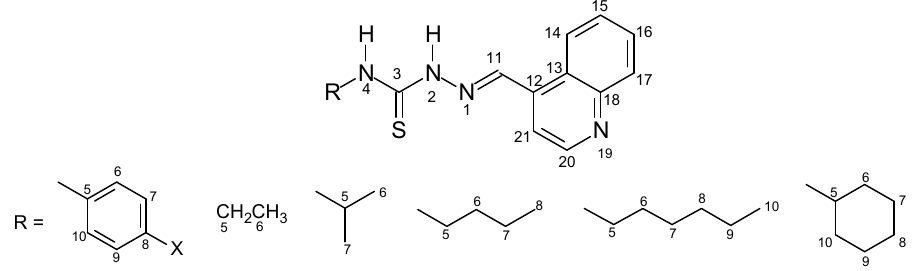
Figure 4. 4-Quinolinecarboxaldehyde series 34–42